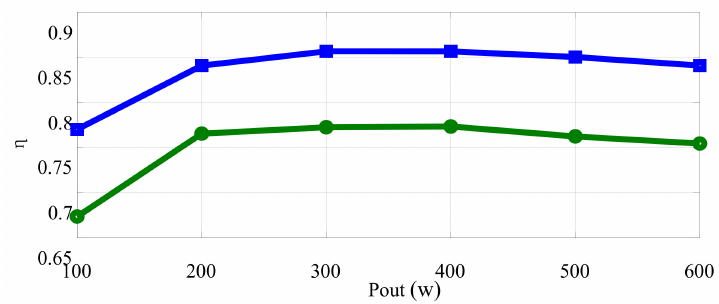
Figure 19. Output efficiency under variable